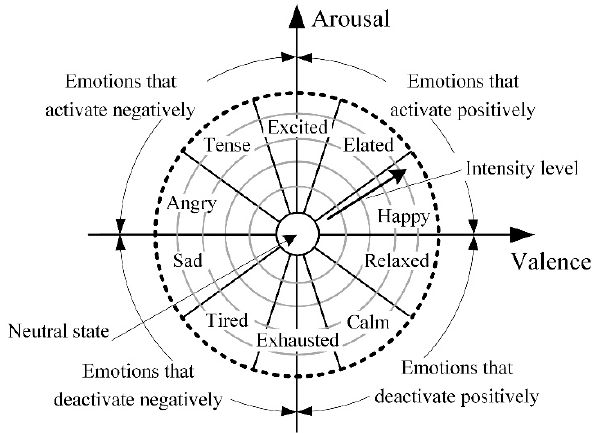
Figure 1. Russel’s circumplex model of emotions.